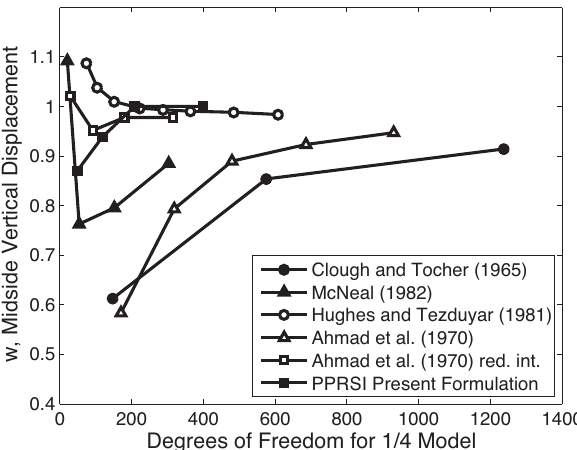
Figure 5: Numerical test example 2 (Scordelis-Lo roof): convergence pattern using the new approach PPRSI related to more classical shell FEs in case of a shell roof under gravity load